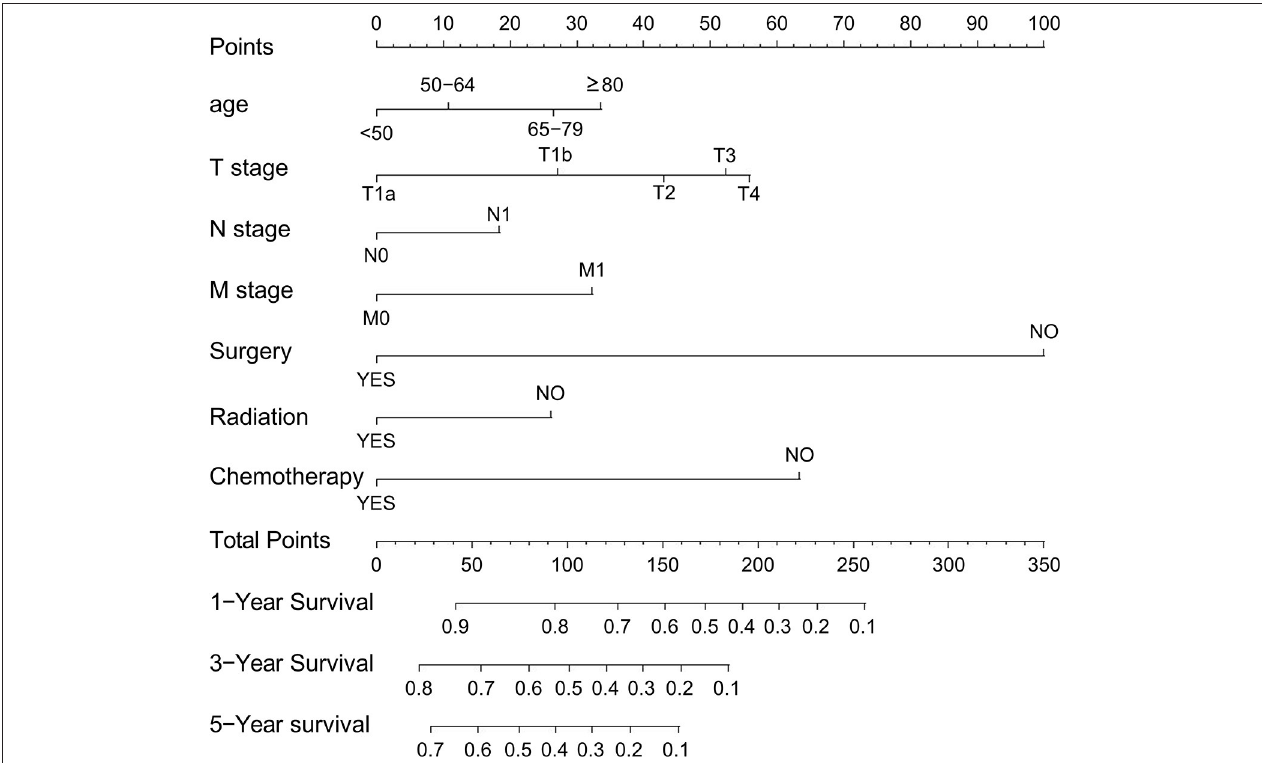
FIGURE 2 | Nomogram predicting 1-, 3-, and 5-year OS of patients with ICC. OS, overall